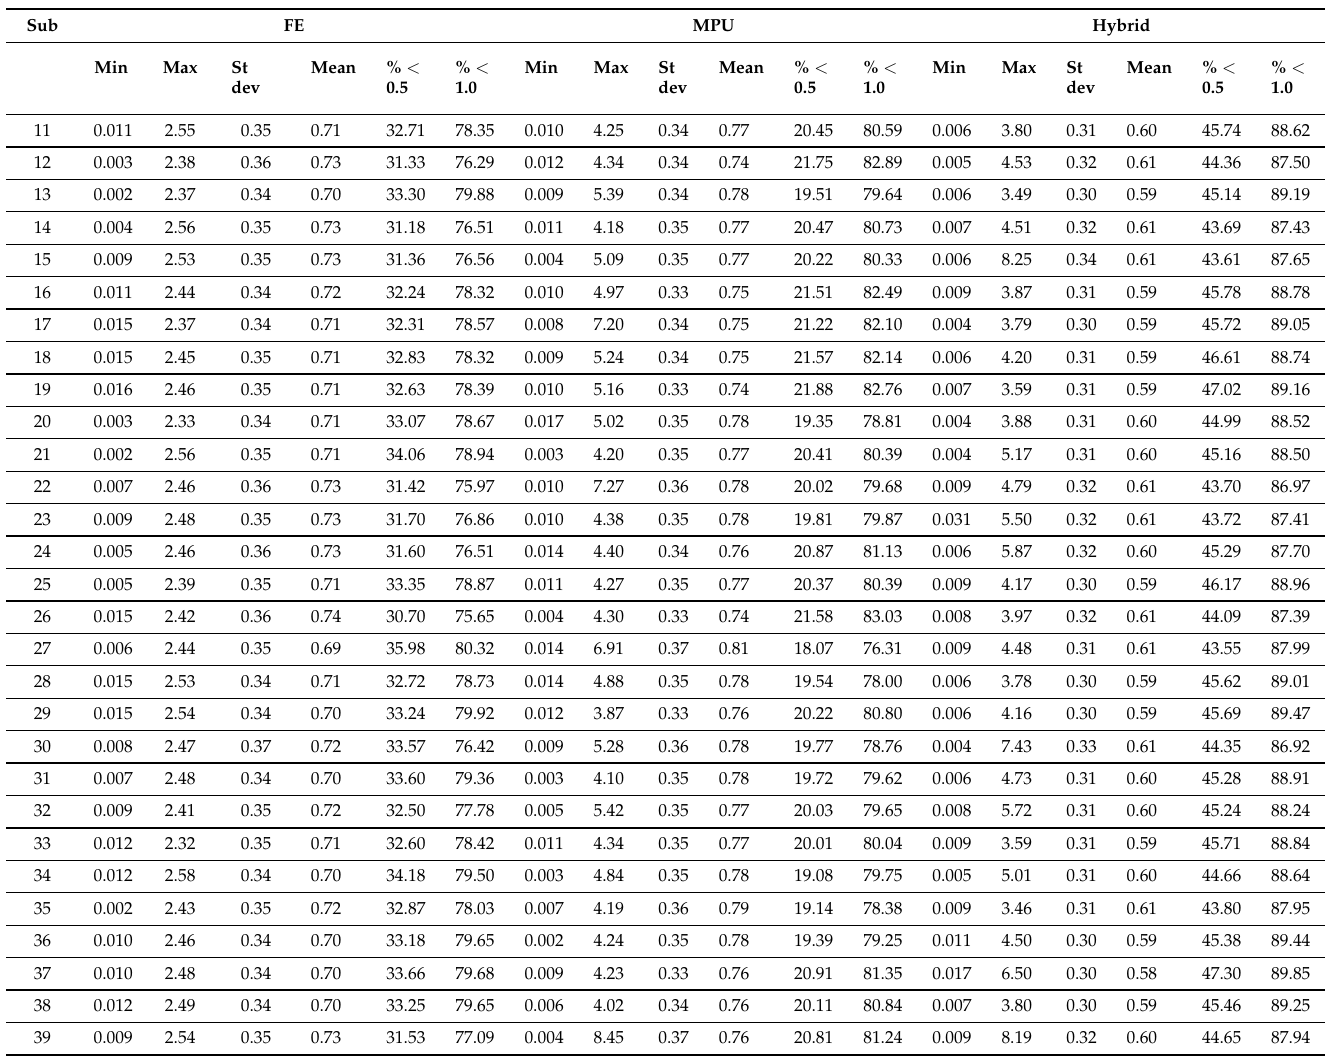
Table A1. Approximation quality of reconstructed surfaces for 29 brain cortices. Metrics are calculated in units of